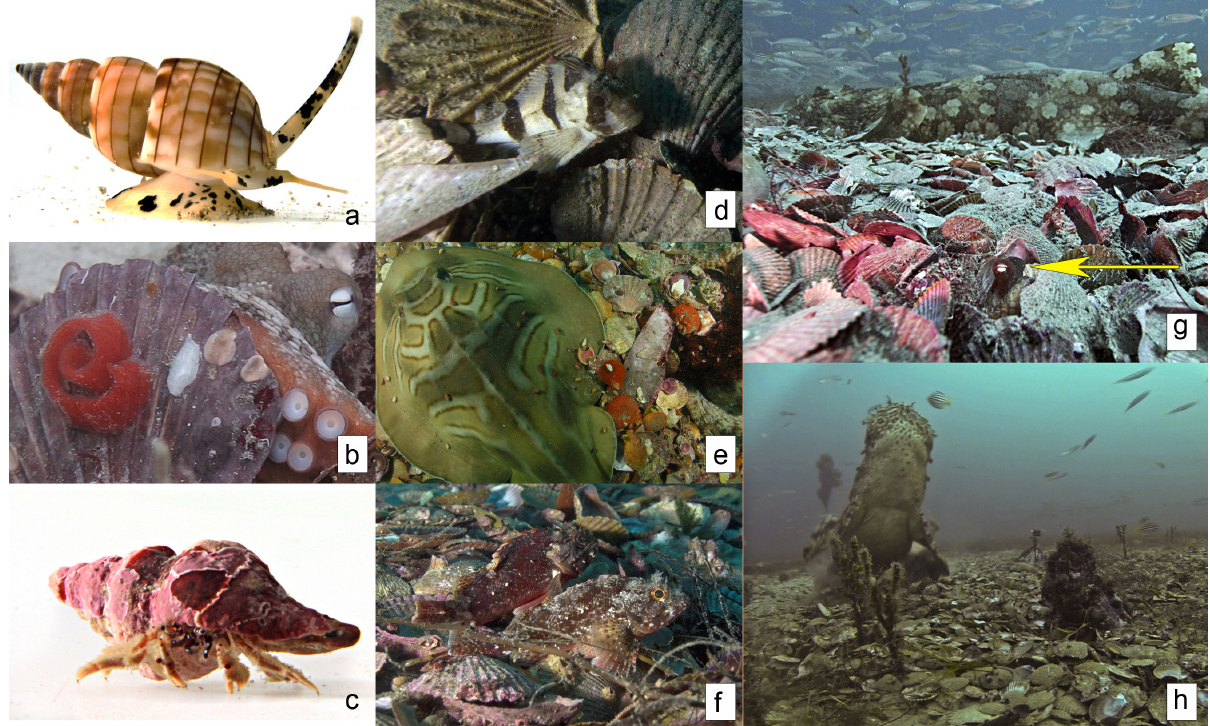
Fig. 6. – Representative examples of fauna of the shell bed, including invertebrates and fishes occupying scallop shells and interstitial spaces. Invertebrates shown (a-c) are snails (a, reticulated dog whelk, Nassarius particeps ), unidentified gastropod eggs (b, on a scallop shell which the octopus ( Octopus tetricus ) is using as cover in its den), and hermit crabs of several species (c, boxer hermit crab Paguristes pugil ). Fishes shown (d-f) are Fortescue (d, Centropogon australis ), banjo ray (e, Trygonorrhina fasciata shown covered with hermit crabs that have crawled over it from the shell bed), and southern red scorpionfish (f, Scorpaena papillosa ), just a few of over 20 fish species recorded on the shell bed. A large ornate wobbegong shark (g-h, Orectolobus halei ), dominates the background while in the foreground an octopus is visible in its den in the shell bed (g, arrow). A school of Green horse mackerel and mado is visible (g, upper left), on which wobbegongs successfully foraged while on the shell bed (h) as caught on video. The scattered remnants of the fish school are visible in the water column. The dark object in the centre foreground is the artifact used as one den; a GoPro camera on a tripod is visible behind and just to the left of the artifact. Images a, c, d and f and g by DS; b, gastropod eggs by PGS; e, banjo ray with hermits by ML; and h, screen capture from